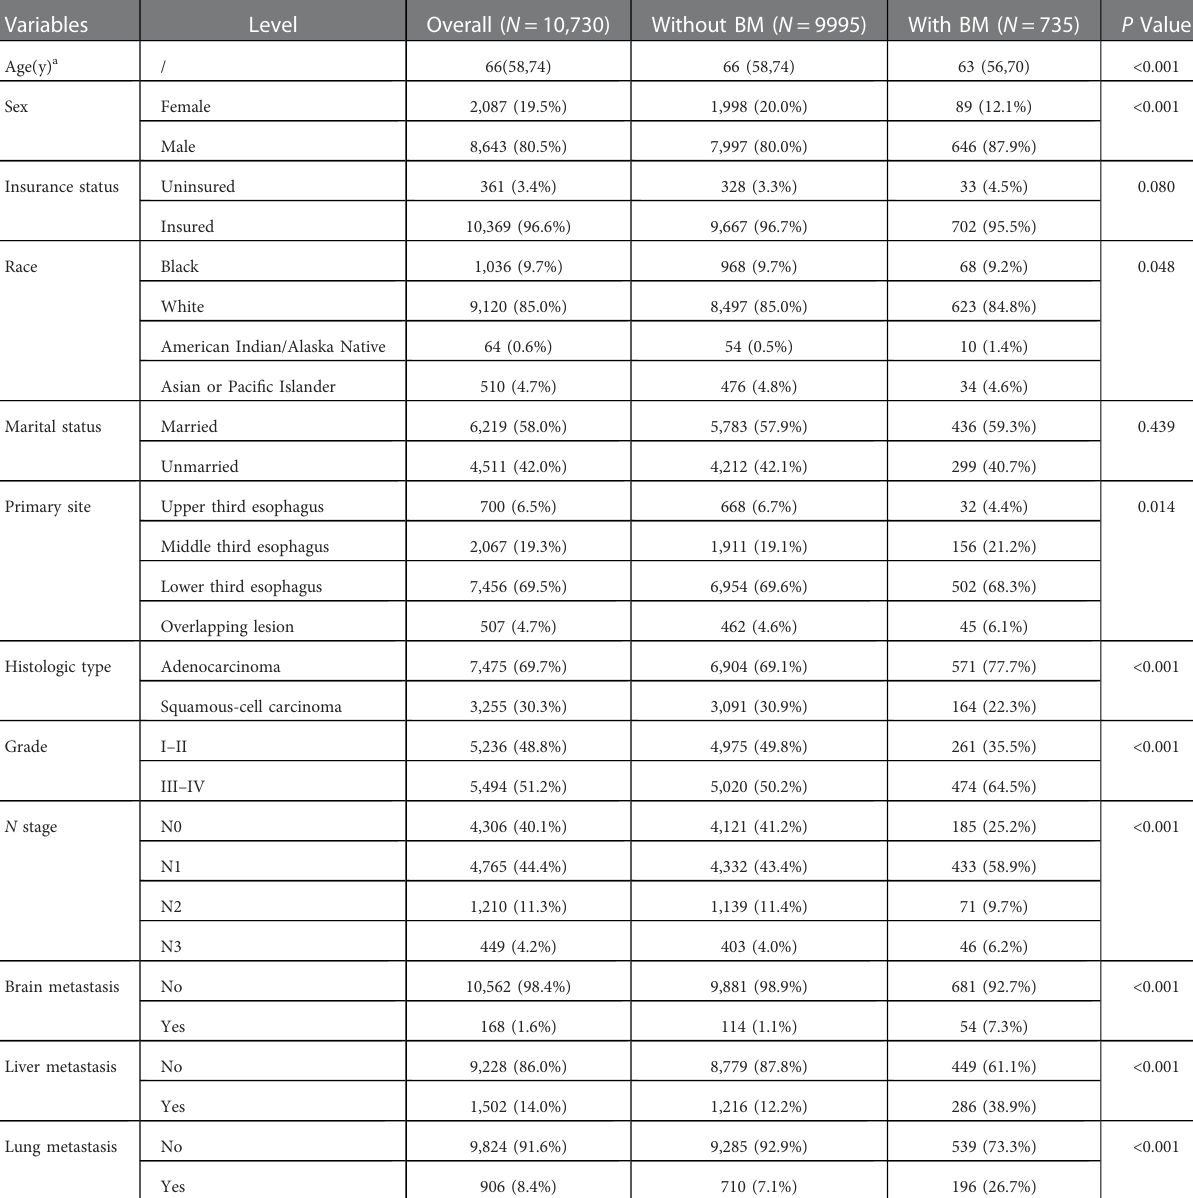
TABLE 1 Clinicopathological characteristics of patients with esophageal cancer.